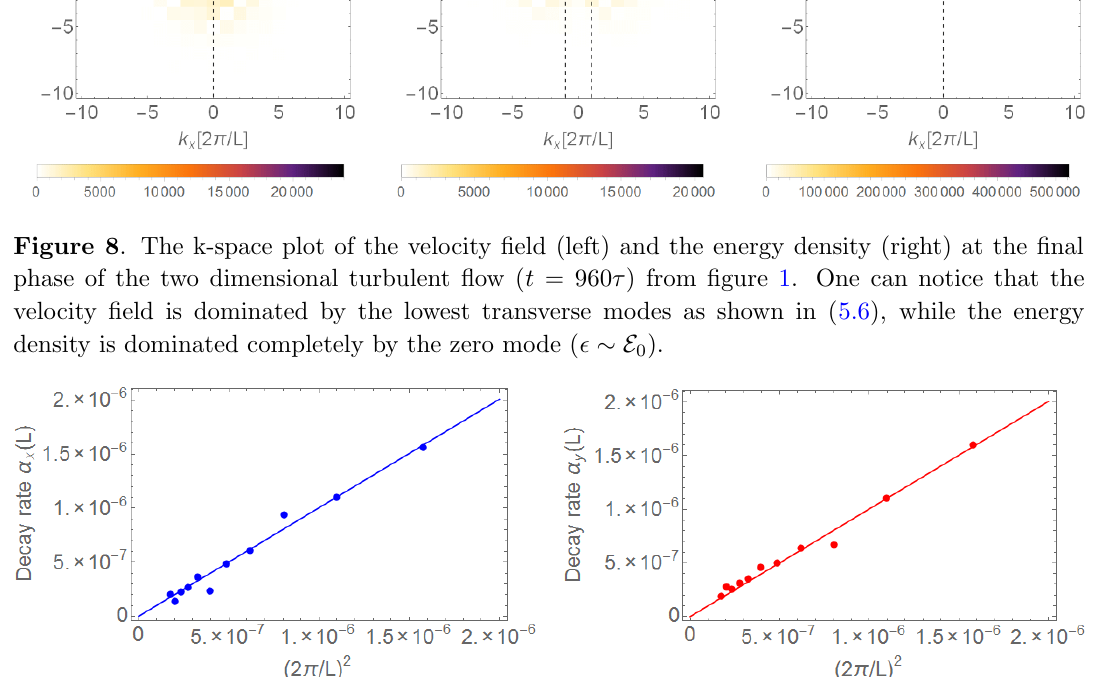
Figure 9 . The decay rate of the velocity (cid:12)elds u x and u y , denoted by (cid:11) x (left) and (cid:11) y (right) at late times as a function of (2 (cid:25)=L ) 2 with L the length of the torus. Box lengths ranged from L = 5000 to L = 15000. The solid lines denote a linear